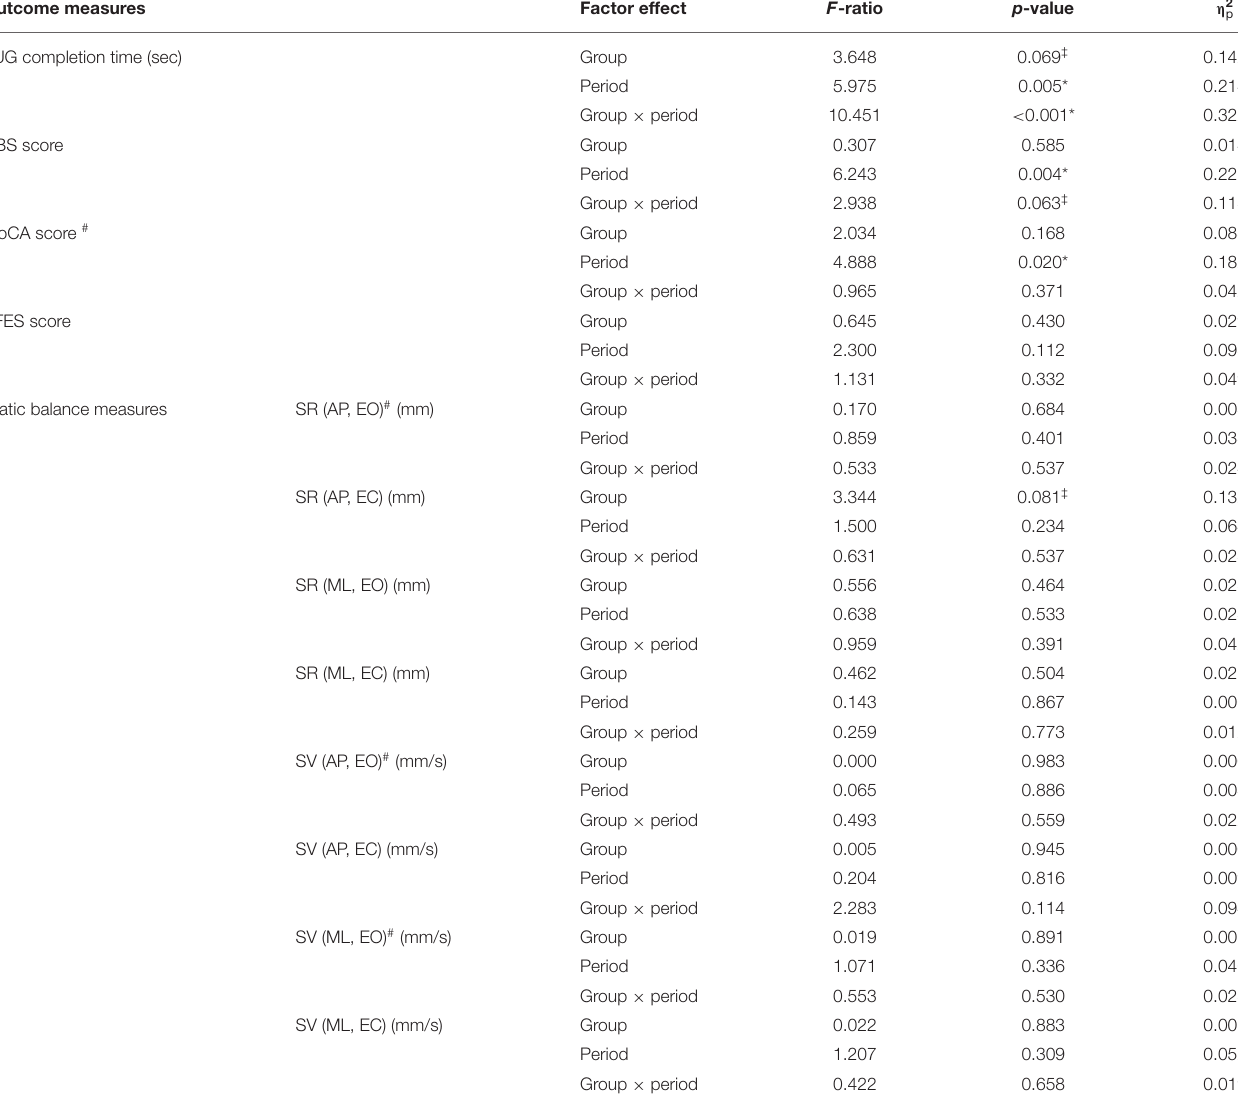
TABLE 3 | Mixed ANOVA results for outcome